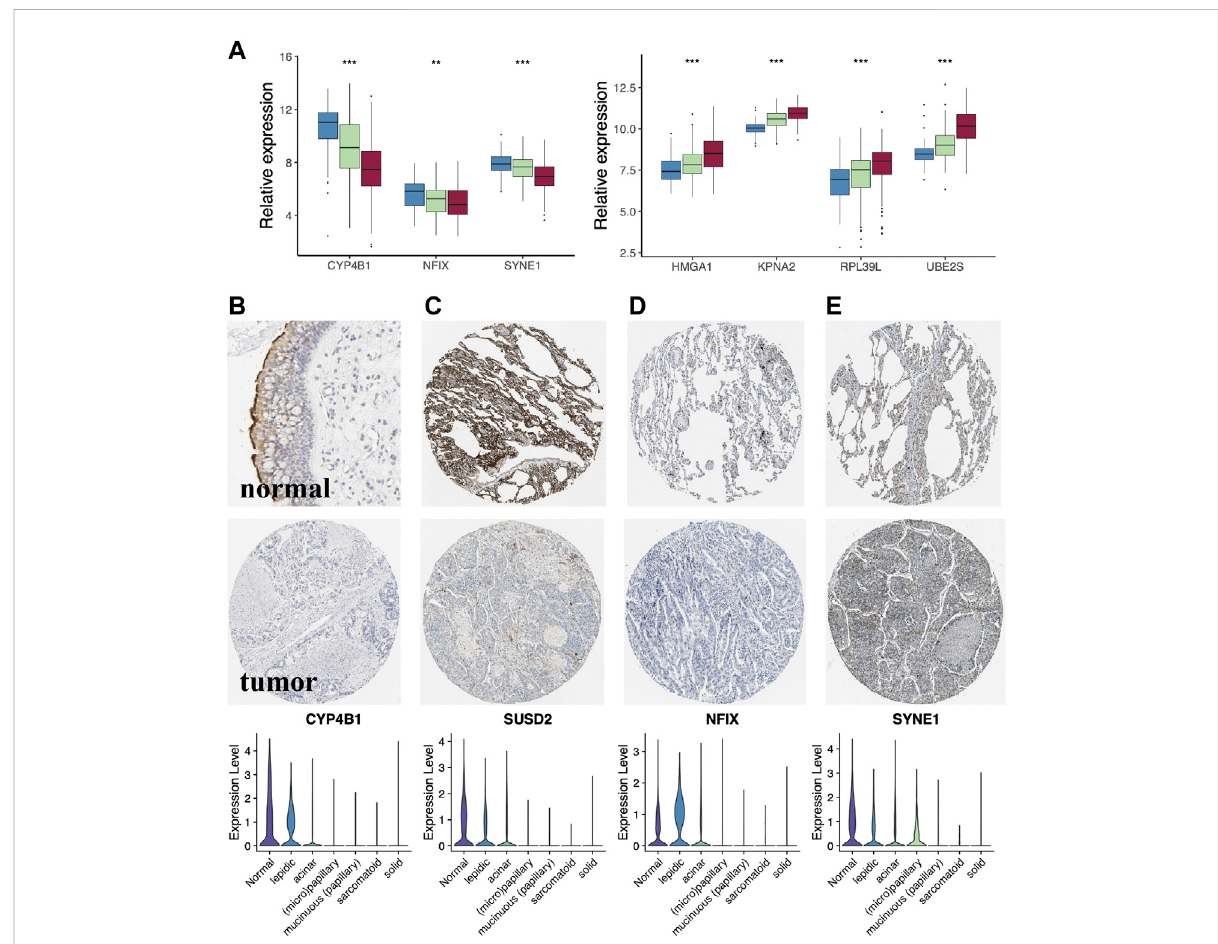
FIGURE 8 The key genes of MYC-signaling signature. (A) Genes highly associated with tumor cell differentiation. (B – E) Expression level of the key genes (CYP4B1, SUSD2, NFIX and SYNE1) in LUAD tumor tissues, normal tissues as well as in single cells with different degrees of